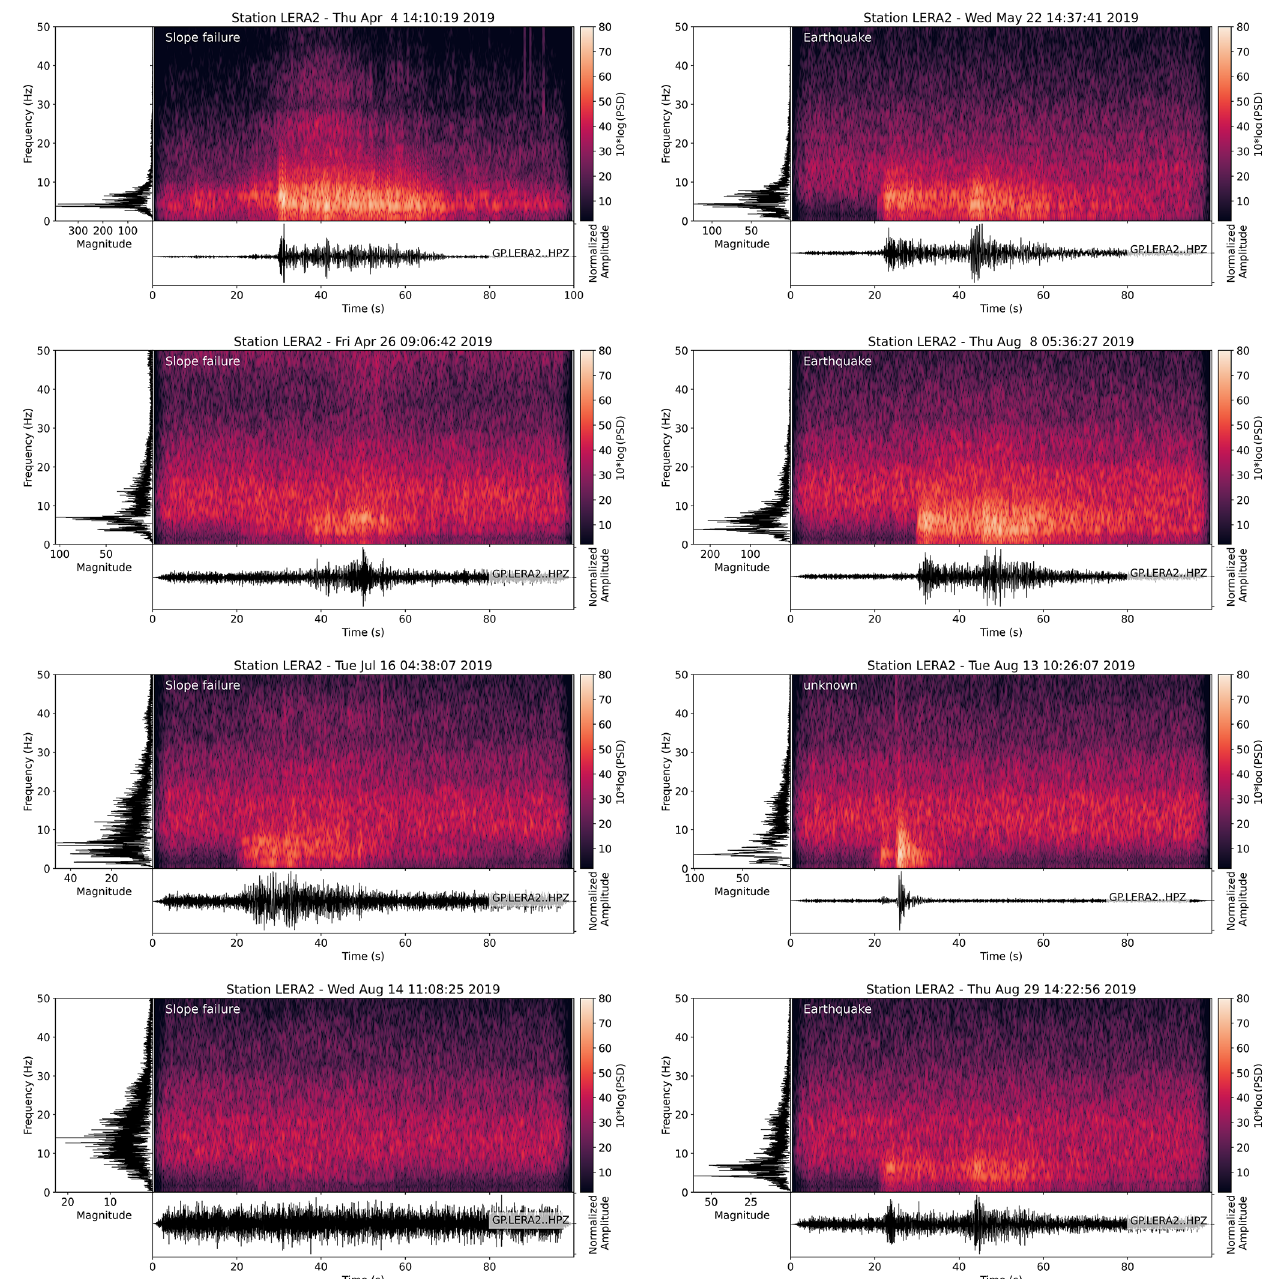
Figure 10. Waveforms, spectrograms, and spectra of all events classified as slope failure in 2019 at Pizzo Cengalo, as well as the missed slope failure on 14 August 2019 (bottom left panel). White labels on spectrograms mark the type of event.